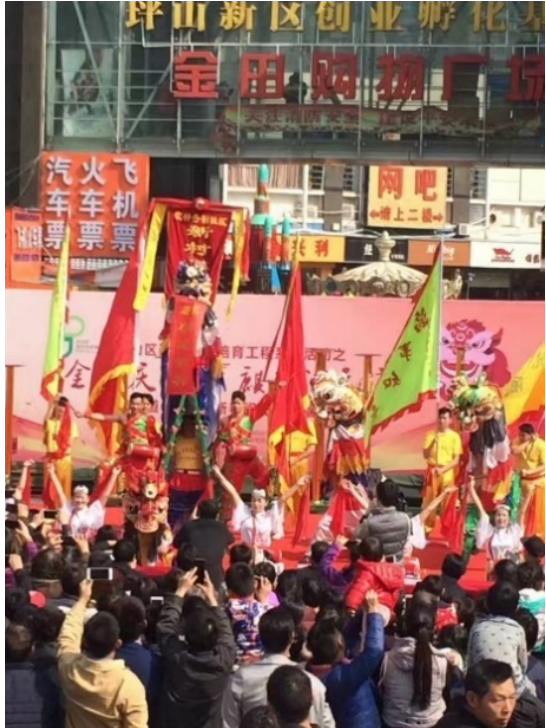
Figure A2. Inheritors of folk dance perform in the square at Lantern Festival.